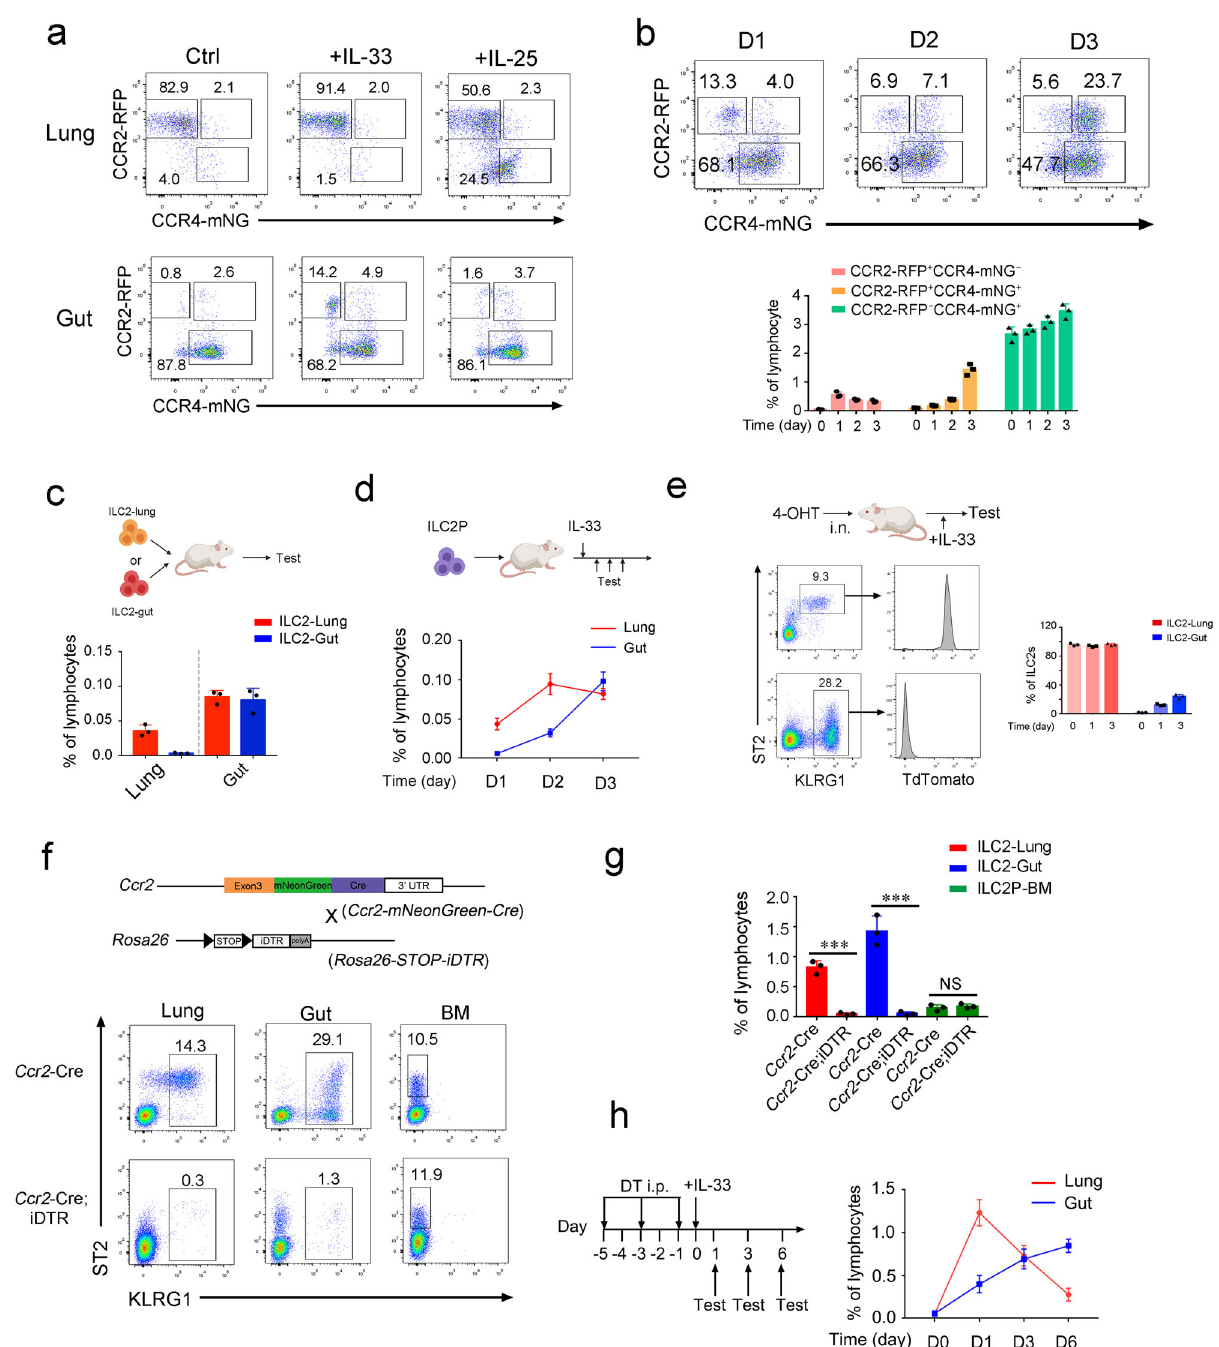
Fig. 3 | CCR2 and CCR4 serve as tissue speci fi c markers of ILC2s. a Violin plots showed ILC2 signature genes in the lung and the intestine. Ccr2 was highly expressed in lung ILC2s and Ccr4 is restricted to intestine ILC2s.Box plots indicate median(middleline),25th,75thpercentile(box)ofthedataandthemaximumand minimumvaluesasendpointsforthewhiskers. b Maturationtrajectoryoflungand intestine ILC2s were analyzed by Monocle pseudotime analysis. c , d Expression of CCR2 and CCR4 on ILC2s. CCR2-mNeonGreen reporter mice ( c ) and CCR4- mNeonGreen reporter mice ( d ) were generated as described in “ Methods ” and analyzed for the expression of CCR2 and CCR4 on ILC2s by fl ow cytometry. Lin - CD45 + CD127 + lymphocytes were gated for analysis of KLRG1 and ST2. (Lin=C- D3e,CD8a,CD19,CD11b,CD11c,Gr1,F4/80,Ter119). e , f CCR2-mNeonGreenandCCR4-